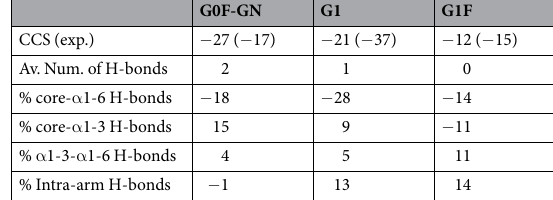
Table 3. Differences in CCS (Å 2 ) and H-bonds between rod-like and globular shapes (X globular − X rod ; X = CCS, Average number of H-bonds, and Percentage of each type of H-bond). The experimental CCS values are given in